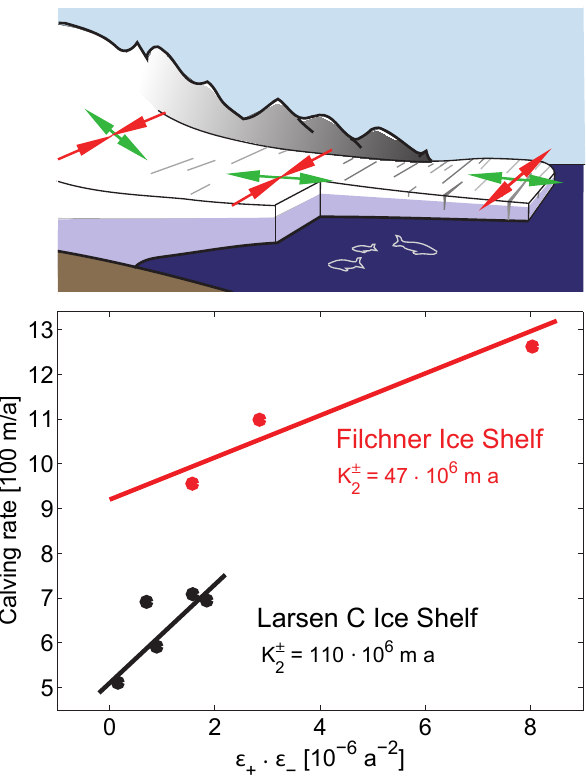
Fig. 1. Concept of eigencalving – Panel a: Schematic illustrating proposed kinematic calving law: the calving rate is proportional to the spreading rates in both eigendirections of the flow which gen- erally coincide with directions along (green arrows) and perpendic- ular to (red arrows) the flow field. In the confined region of the ice shelf, e.g. in the vicinity of the grounding line, convergence of ice flow perpendicular to the main flow direction yields closure of crevasses, inhibits large-scale calving and stabilizes the ice shelf. Near the mouth of the embayment, the flow field expansion occurs in both eigendirections and large-scale calving impedes ice-shelf growth onto the open ocean. Panel b: The observed calving rate determined as the ice flow at the calving front increases with the product of the two eigenvalues which is proposed here as a first- order kinematic calving law in Eq. (1). Details on the data can be found in